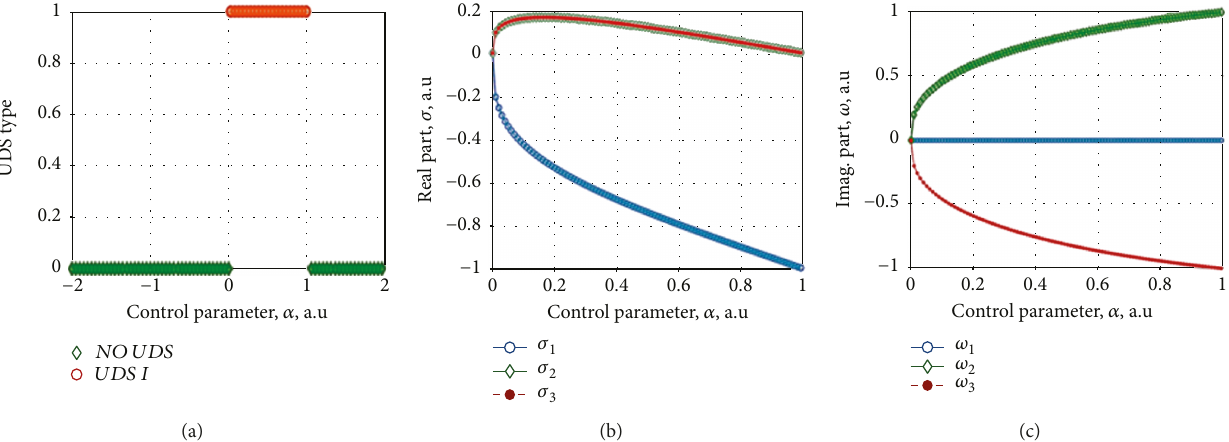
Figure 1: Eigenvalues analysis as a function of the control parameter α . (a) Control parameter analysis showing the UDS I region. (b) and (c) real and imaginary parts for the UDS I, respectively.